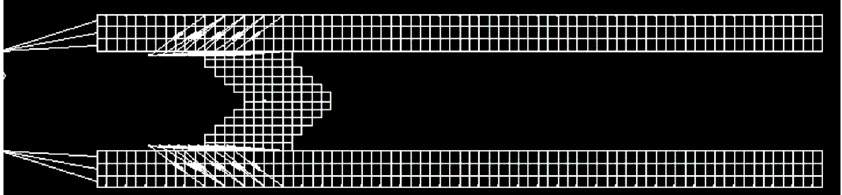
Figure 9. Screenshot of a planar lateral view of the launcher showing the discretization adopted for the strong interaction analysis. Only the active auxiliary branches used to model the sliding contacts are shown. The leftmost segments represent the connections to the compulsator terminals.